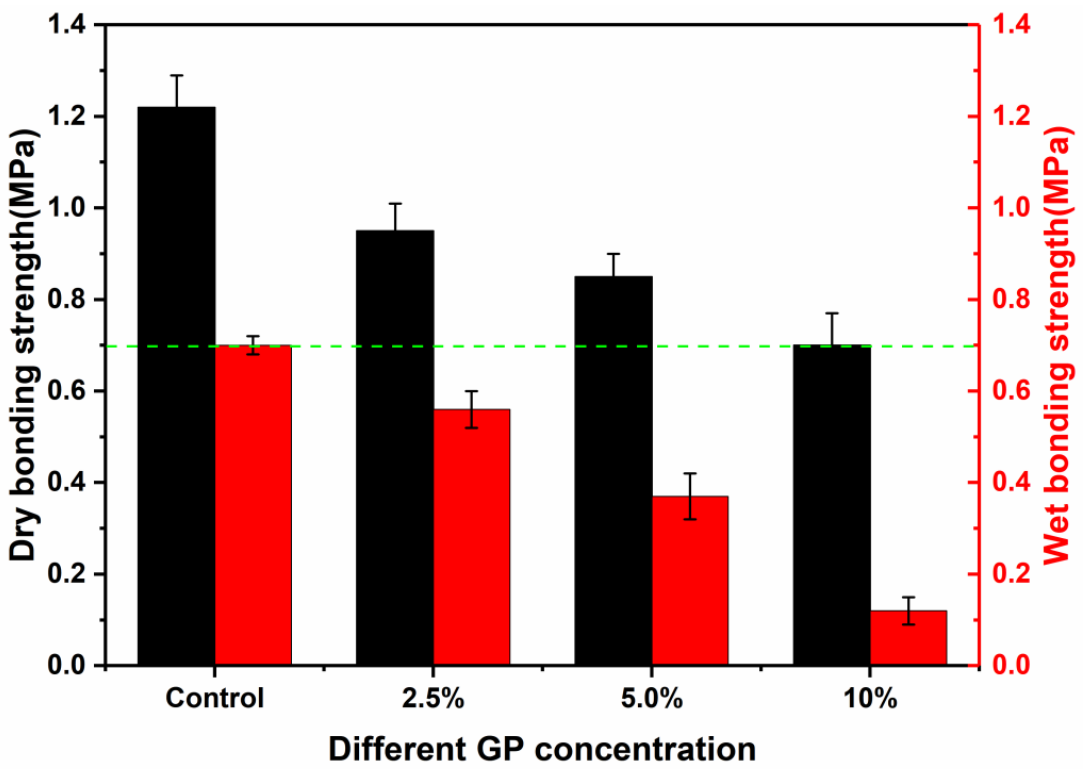
Figure 10. Dry and wet bonding strength of different GP concentration modified wood, glued by UF resin.